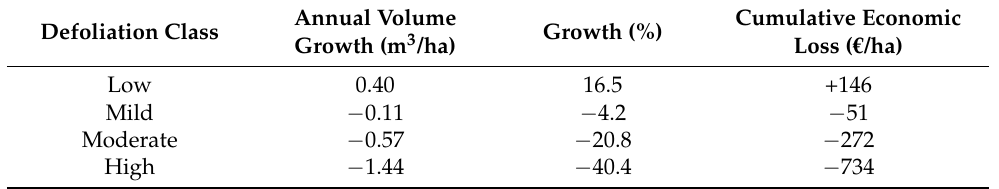
Table 3. Volume growth and economic impact within the defoliation classes per hectare. Volume growth is presented in m 3 per hectare per year and economic loss in euros per hectare for the whole outbreak period (11 years). Values indicate growth and economic losses compared with the reference period. Values of economic impact are converted to correspond to year 2020.